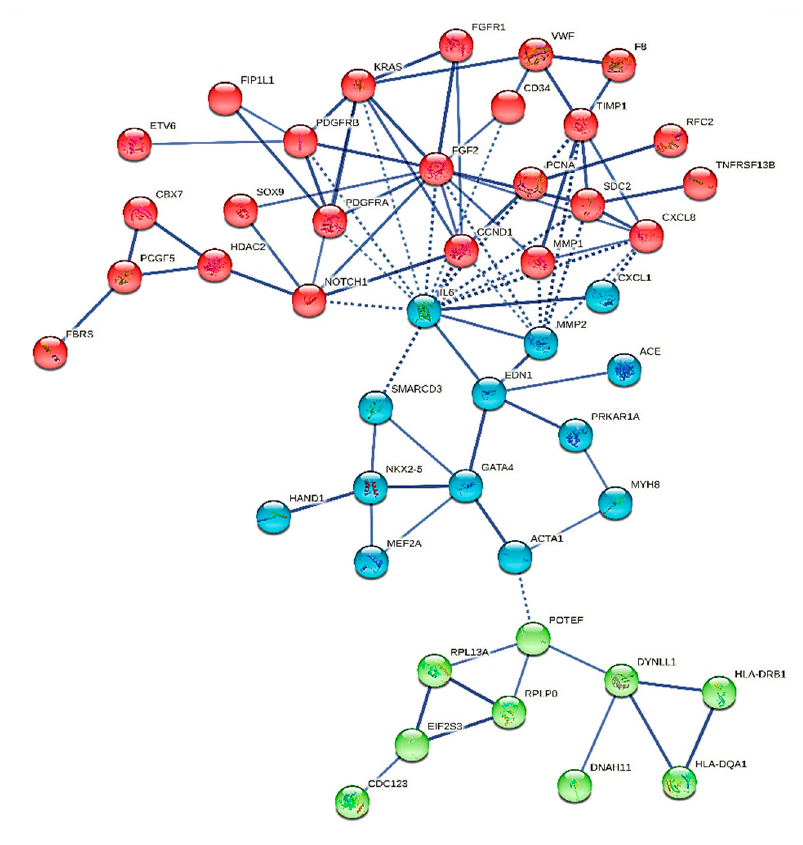
Figure 2. The heart undifferentiated sarcoma interactome.